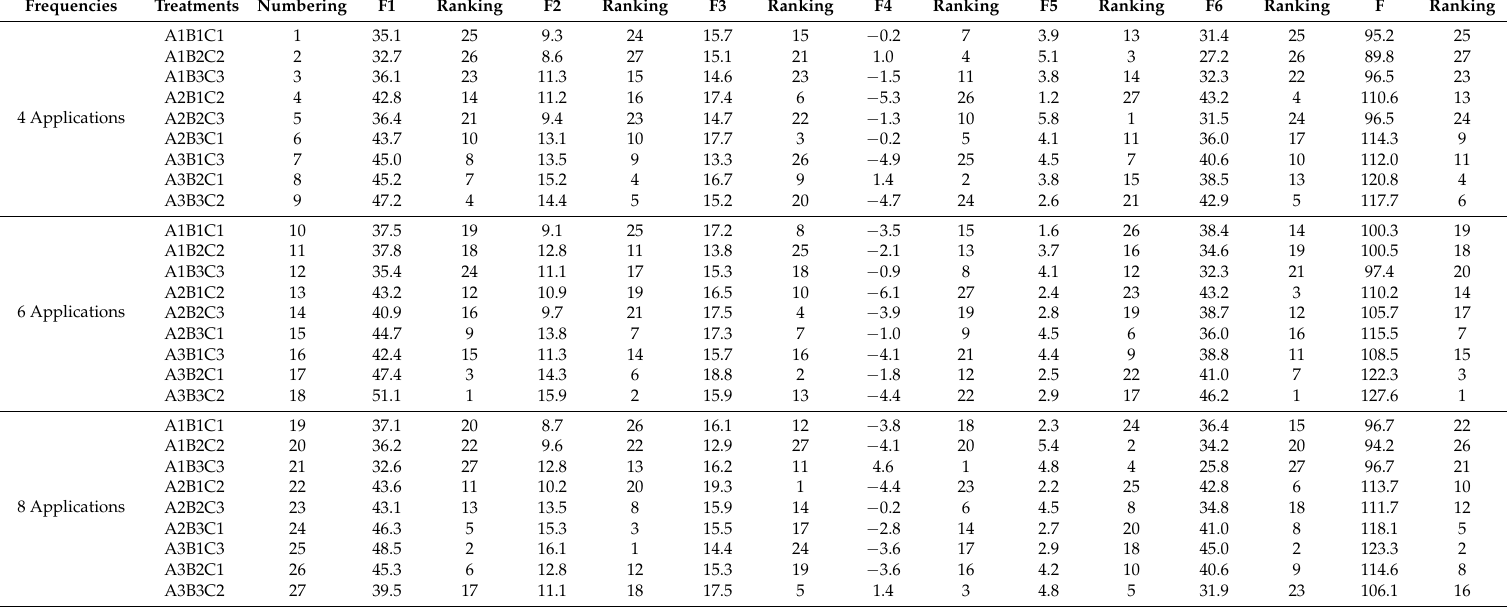
Table A2. Comprehensive score for each seedling